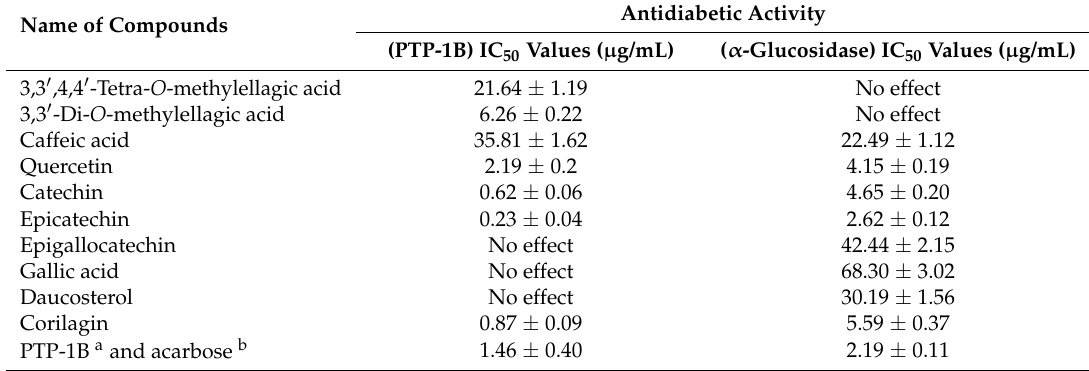
In vitro antidiabetic activity (as IC 50 values) of isolated major compounds from Geranium